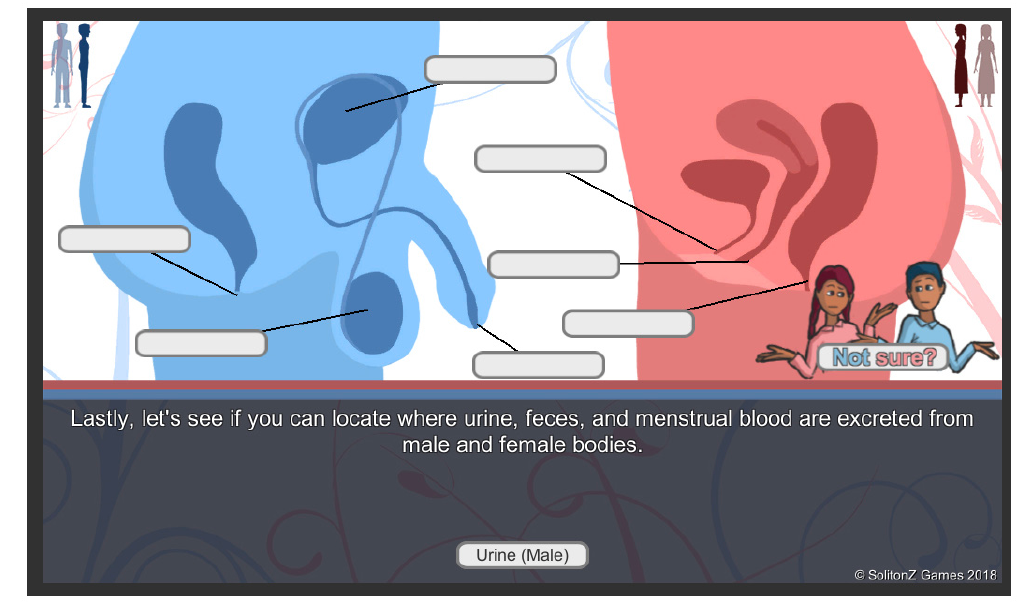
Figure 3. Final anatomy screen from